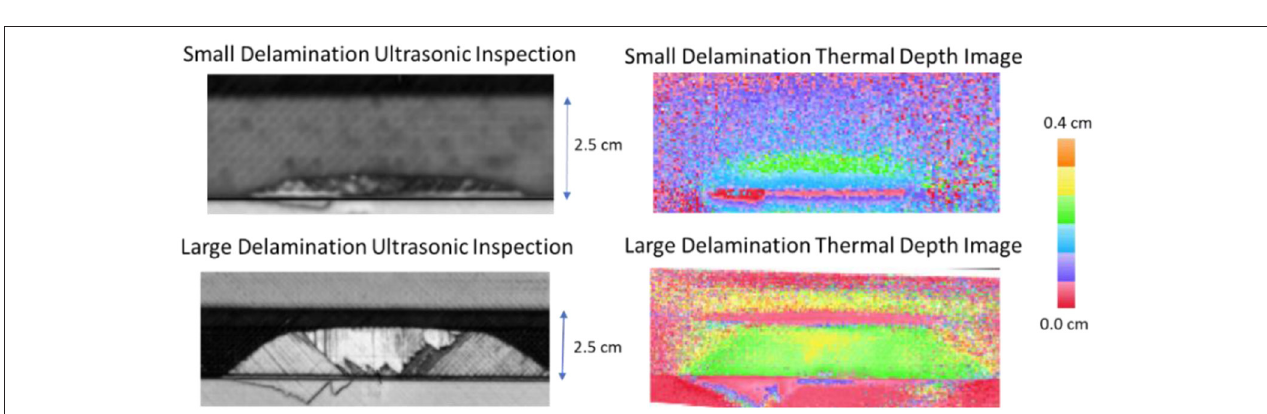
FIGURE 11 | Examples of model curve fit to data for both small delamination and large delamination.